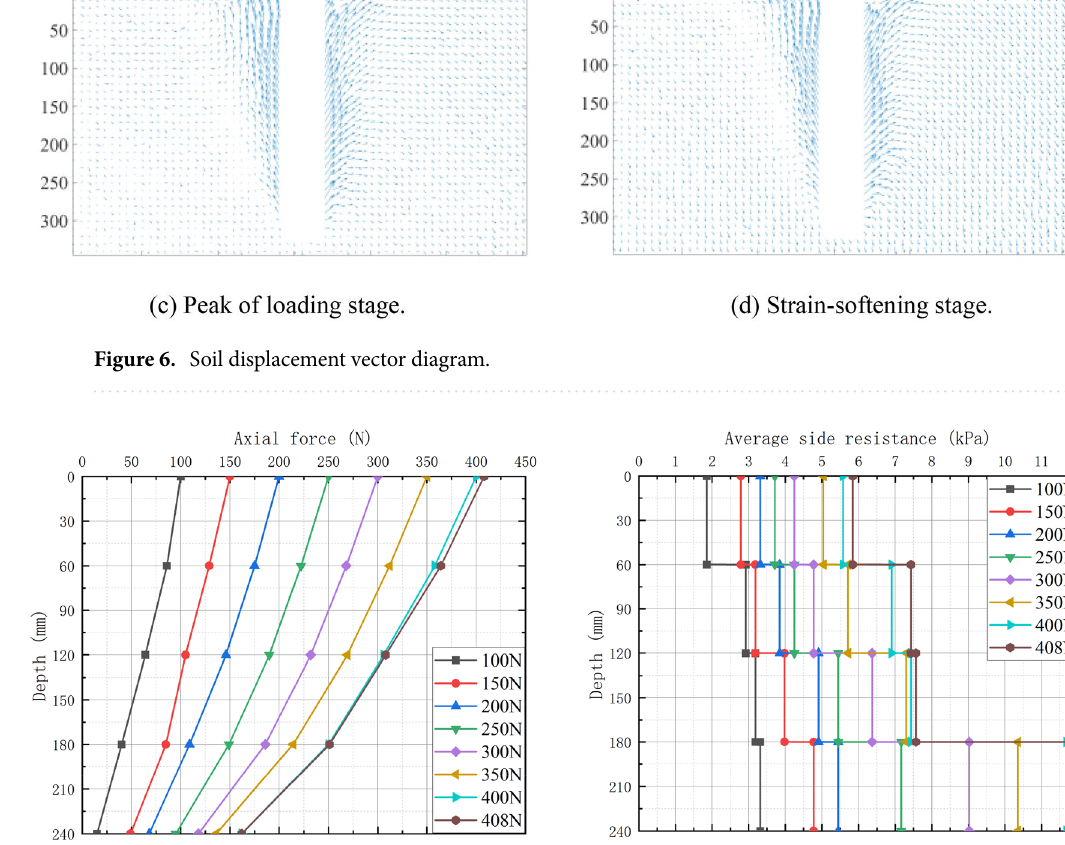
Figure 7. Axial force and average lateral friction resistance along the model